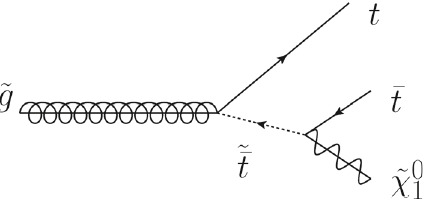
Fig. 60 Feynman diagram describing the gluino decay in a top quark pair and a neutralino